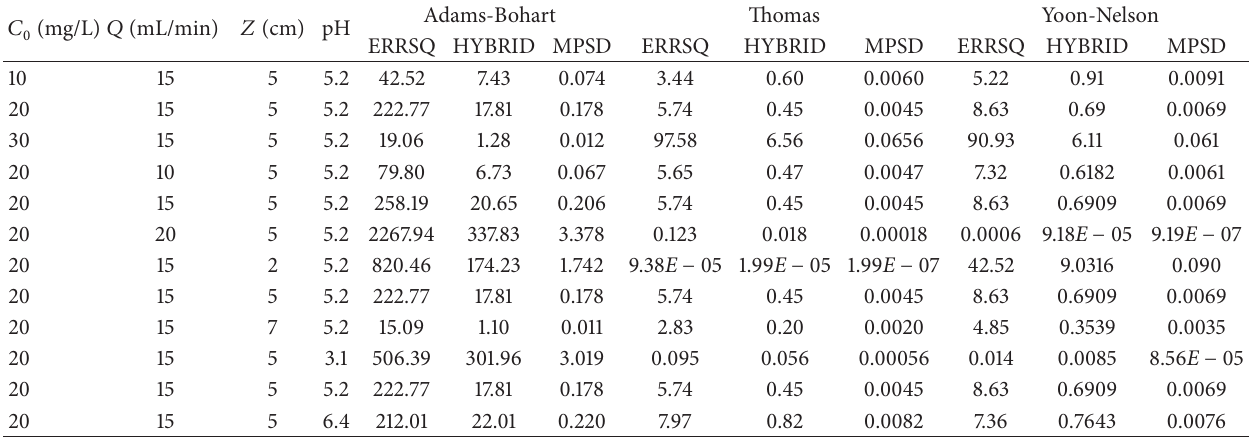
Table 5: Error function values of the models for lead adsorption by CRSD.